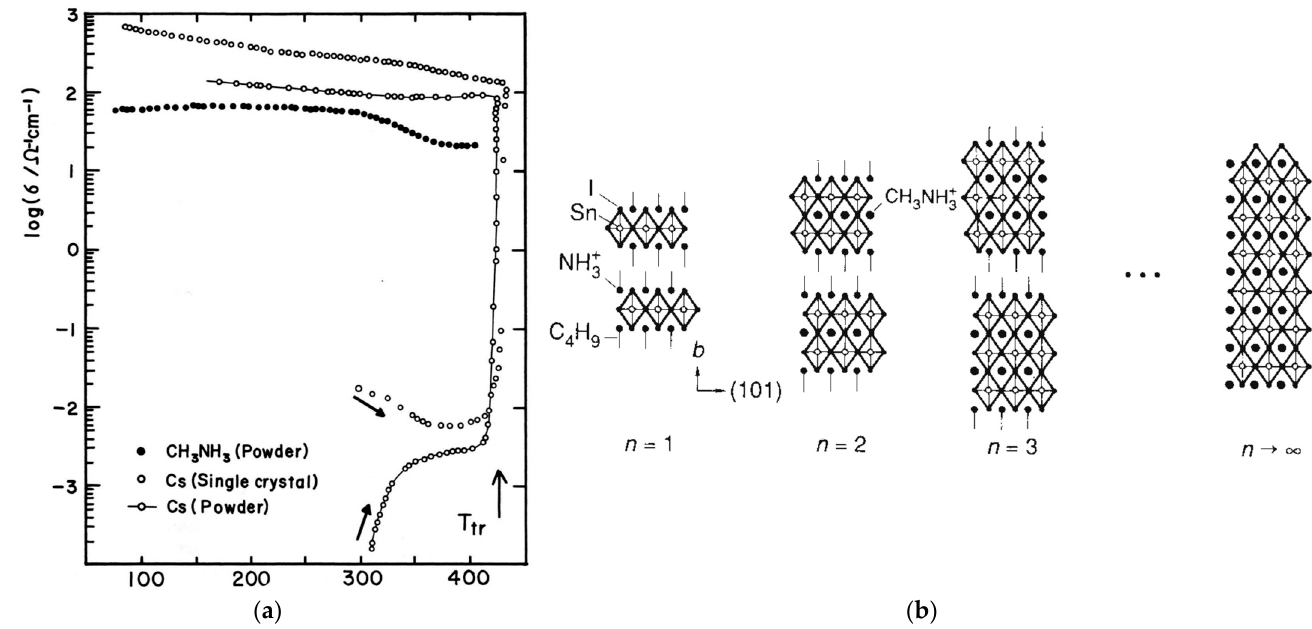
Figure 1. ( a ) Electrical conductivity as a function of temperature of CsSnI 3 and MASnI 3 . Reproduced with permission [39]. Copyright 1990, De Gruyter, and ( b ) schematic representation of BA incorpo- ration in perovskite materials with n = 2, 3, and ∞ , reproduced with permission [43]. Copyright 1995, Nature publishing group.